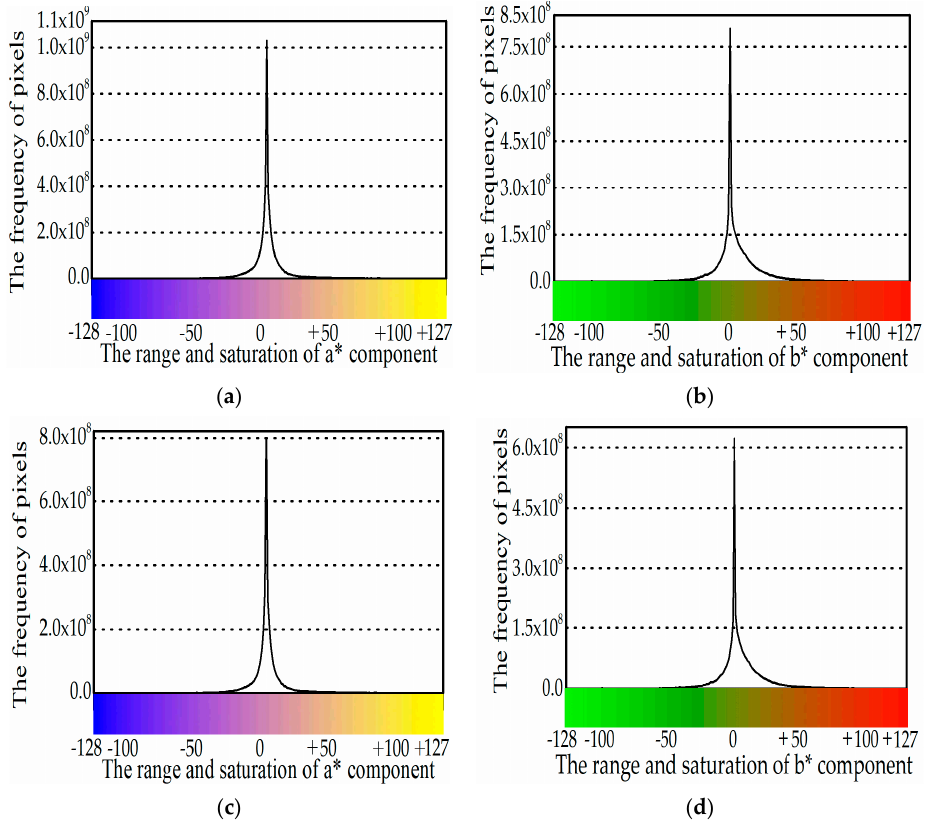
Figure 1. The frequency of pixels on: ( a , b ) Caltech-256 and ( c , d ) 10% of Caltech-256.